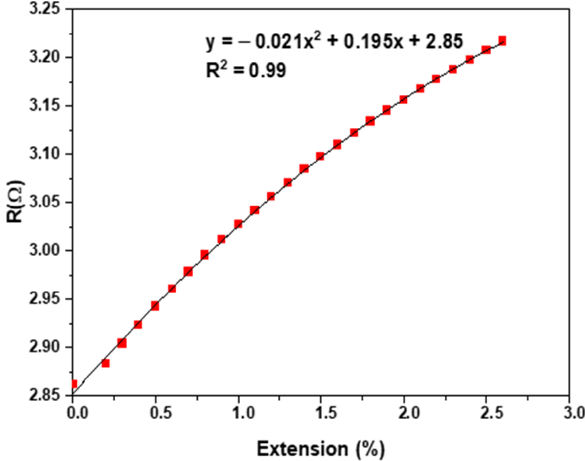
Figure 6. Stress-dependent electrical resistance of the conductive